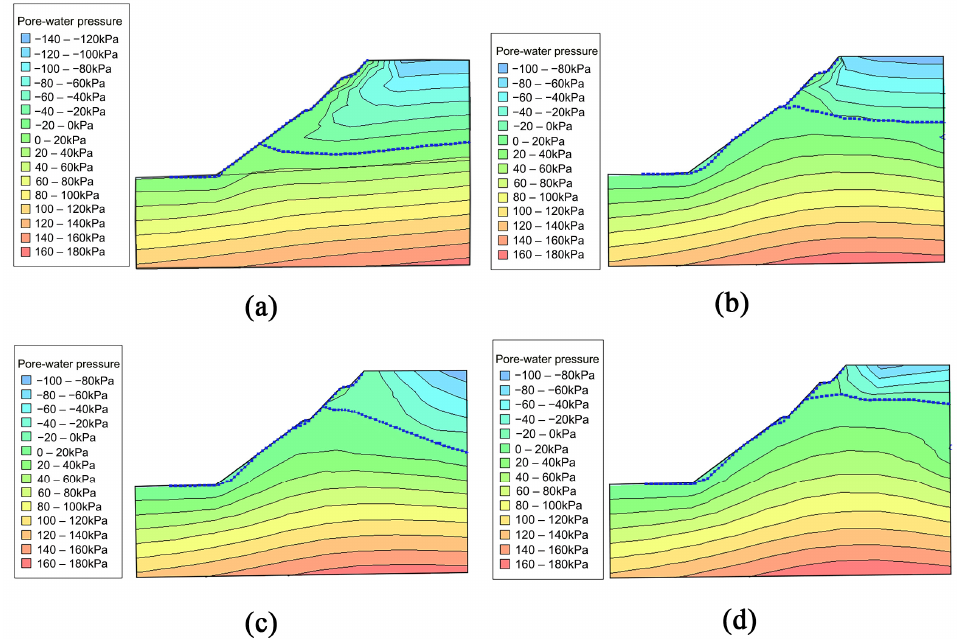
Figure 4. Pore water pressure distribution for each working condition, where the blue dashed line is the phreatic line. ( a ) Working condition I; ( b ) Working condition II; ( c ) Working condition III; ( d ) Working condition IV.